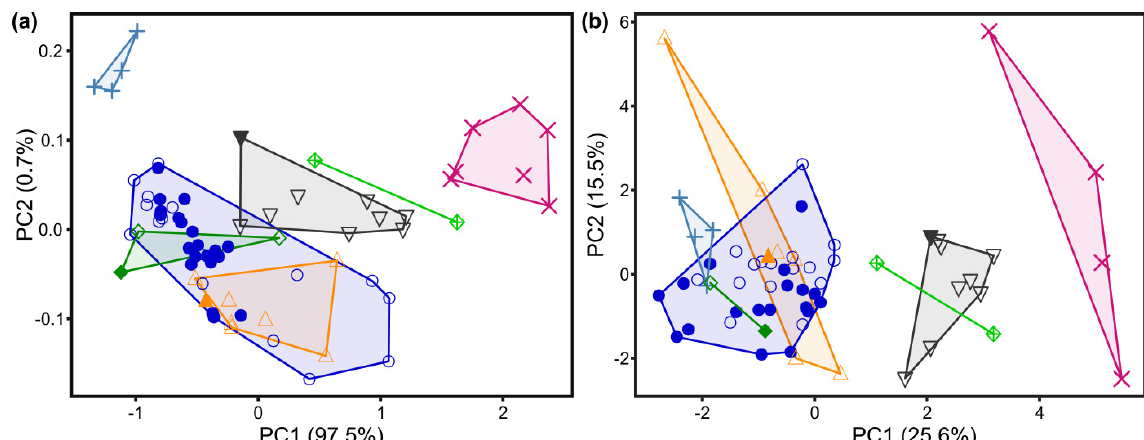
Fig. 4. Scatterplots of PC2 against PC1 of the PCA on (a) 24 log-transformed measurements (n = 69) and (b) on 15 meristics (n = 62). Specimens of group A, the filled circles (●) represent the genetically analysed specimens, the open circles (○) indicate the additional specimens. Specimens of E. alberti (Poll, 1939) (lectotype) (♦), E. alberti (paralectotypes) (◊), specimens from Tshambi ( ), E. cercops (Whitehead, 1960) (holotype) (▲), E. cercops (paratypes) ( ), E. mimus (Boulenger, 1912) (lectotype) (▼), E. mimus (paralectotypes) ( ▼ ), E. perince (Rüppell, 1835) (syntypes) (+) and E. stigmatopygus (Boulenger, 1903) (syntypes) ( × ).